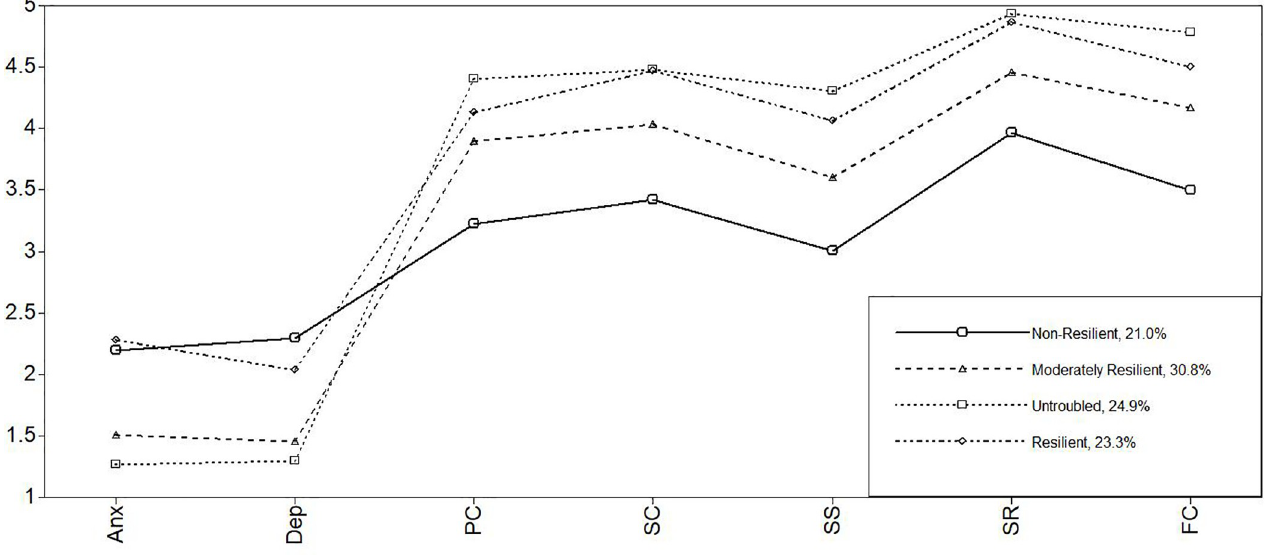
Fig 3. Latent profiles of Greece. Note . Anx = anxiety; Dep = depression; PC = personal competence; SC = social competence; SS = structured style; SR = social resources; FC = family cohesion.